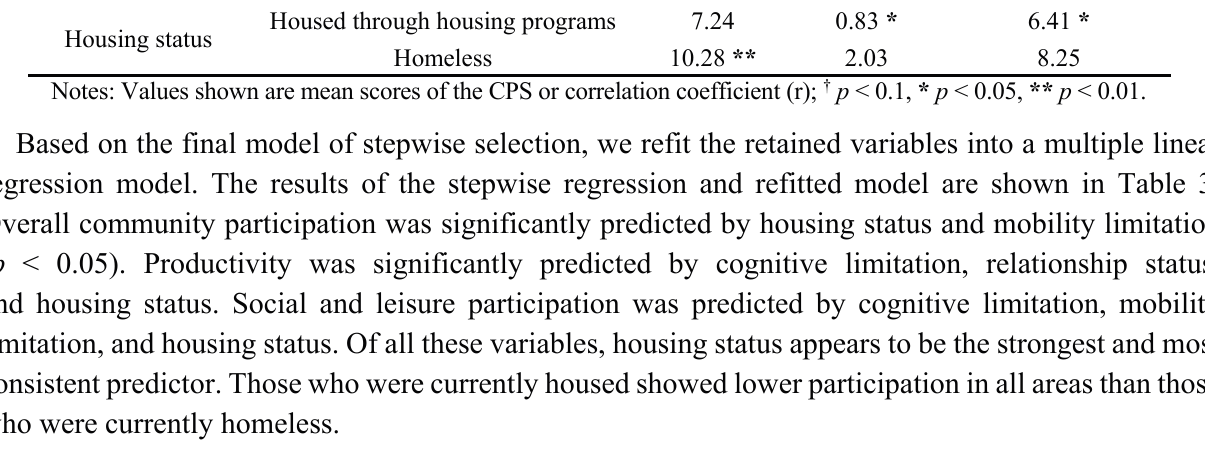
Table 3. Multiple regression model of community participation and its subdomains (N = 120). Overall N